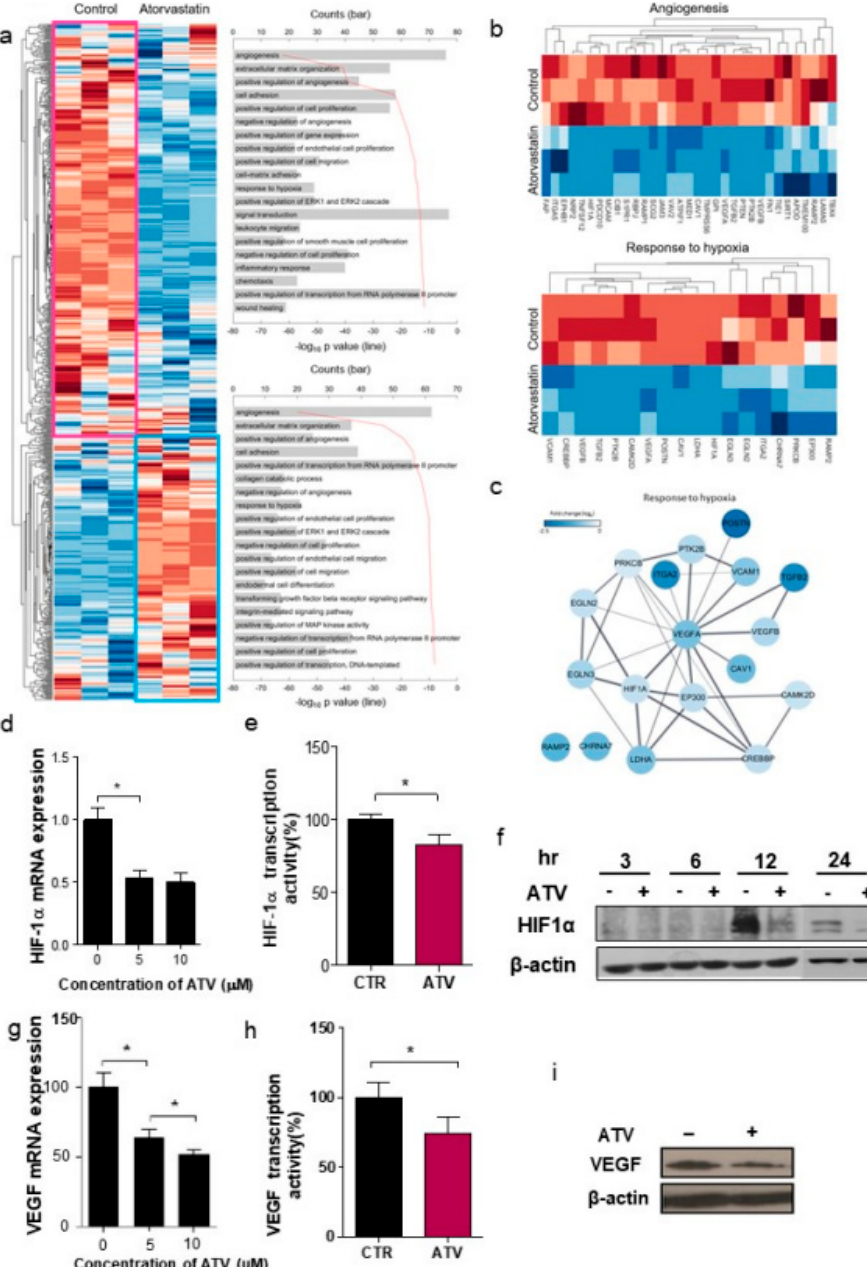
Figure 3. Atorvastatin suppresses HIF-1 α and VEGF, leading to reduced tumor angiogenic activity in atorvastatin-treated cells. ( a ) NanoString analysis and unsupervised algorithms. Using 718 probe set with highest variable gene expression, two clusters of co-expressed genes were defined using hierarchical clustering. ( b ) Two clusters of co-expressed genes for angiogenesis and response to hypoxia. ( c ) String network analysis for response to hypoxia. HIF-1 α , VEGF A, and VEGF B were highly correlated. ( d ) mRNA level of HIF-1 α by qRT-PCR. qRT-PCR revealed that ATV attenuated the mRNA levels of HIF-1 α in ATV-treated Raji cells. ( e ) Transcriptional activity of HIF-1 α in ATV-treated cells. ( f ) HIF-1 α protein level by western blotting. mRNA and protein level of HIF-1 α , and transcriptional activity of HIF-1 α also decreased in ATV-treated cells. The mRNA level of HIF-1 α by qRT-PCR ( g ) The mRNA level of VEGF by qRT-PCR. qRT-PCR revealed that ATV attenuated the mRNA levels of VEGF in ATV-treated Raji cells. ( h ) Transcriptional activity of VEGF. ( i ) VEGF protein level by western blotting. The mRNA and protein level of VEGF, and transcriptional activity of VEGF were also decreased in ATV-treated